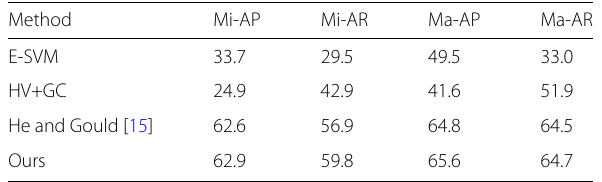
Table 4 Performance comparison of object labeling on